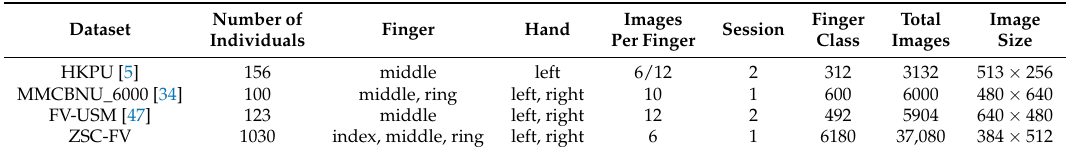
Table 1. Finger-vein